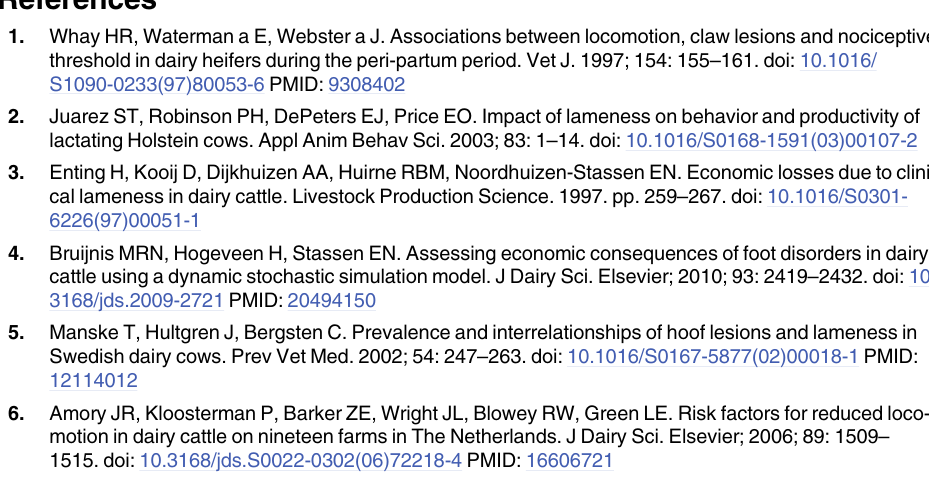
S1 Table. One-hour summaries. Table of one-hour summaries of all animals and days included in the study. S2 Table. Twenty-four-hour summaries. Table of 24-hour summaries of all animals and days included in the study. S3 Table. Data used for